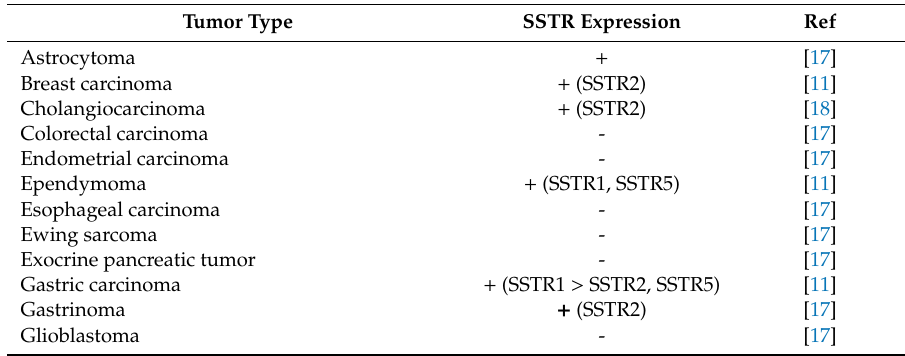
Table 1. SSTRs expression in di ff erent tumor